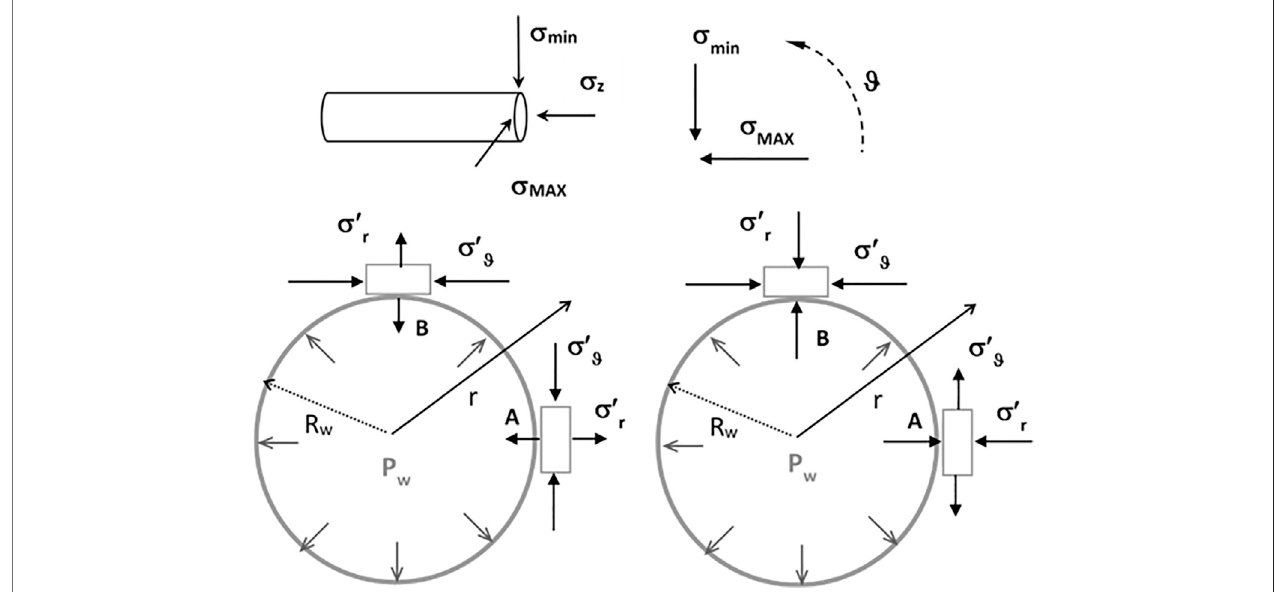
FIGURE2| Sketchofawellboredrilledalongaprincipaldirection.Far- fi eldstressesare σ min , σ MAX ,and σ z .Therockissaturatedandtheporepressure p f atapoint ofthecontinuummedium hasthesame magnitude inalldirections.Theinducedstressesaretheradialstress σ ′ r ,tangentialstress σ ′ ϑ ,andtheaxialstress σ ′ axis thatacts normal to the cross section of the wellbore. The cross sections of the wellbore report the possible positive and negative radial σ ′ r and tangential stress σ ′ ϑ .